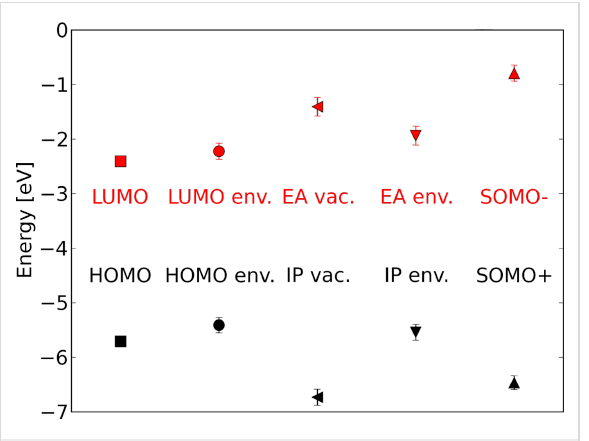
Figure 8: Energy levels of Al(Op) 3 calculated with different conditions, namely, HOMO and LUMO in vacuum (vac.) and in a self-consistent electrostatic environment (env.), with electron affinity (EA) and ioniza- tion potential (IP) in vacuum and environment and SOMO + and − orbitals in